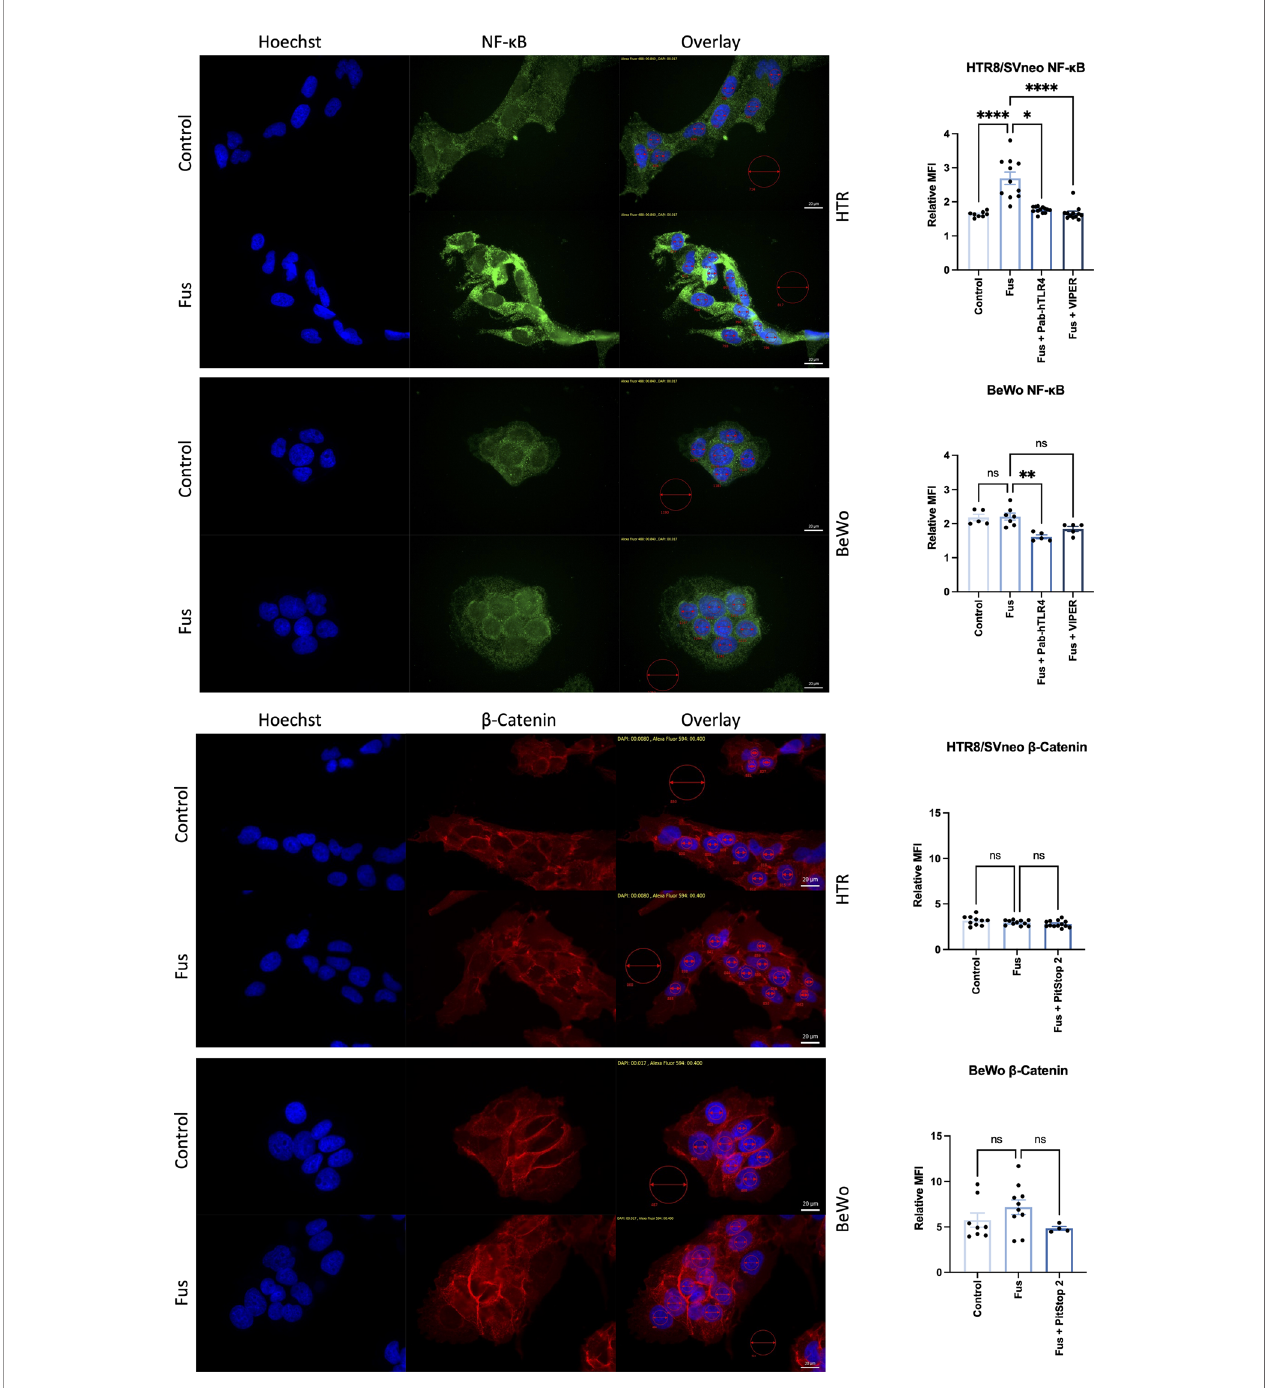
FIGURE 6 | Inactivated F. nucleatum induces NF- k B and b -catenin nuclear translocation. Immuno fl uorescence of NF- k B (top; green) and b -catenin (bottom; red) of untreated or inactivated F. nucleatum -treated (1 h, MOI = 1) HTR8/SVneo and BeWo cells. Some wells were previously treated with a neutralizing antibody against TLR4 (PAb-hTLR4 (5 µg/mL), the viral inhibitory peptide of TLR4 (VIPER; 5 µM) or Pitstop 2 (known to interfere with E-cadherin/ b -catenin signaling) 1 h before bacteria treatment. Nuclei were stained with Hoechst 33258 (blue). Pictures were taken at 60× and the mean fl uorescence intensity (MFI) of each channel were quanti fi ed in the nuclei (small red circles). All pictures were taken using the same exposure time (green channel: 840 ms; red channel: 400 ms; blue channel: 17 ms). Data (left) depict the MFI (mean ± SEM) of either NF- k B or b -catenin normalized to background (big red circle) for each picture shown. Data comparison was performed by ANOVA Kruskall-Wallis test with Dunns multiple comparison test using F. nucleatum treated cells as control ( “ Fus ” column). *p adj < 0.05; **p adj < 0.01; ****p adj < 0.0001; ns, not signi fi